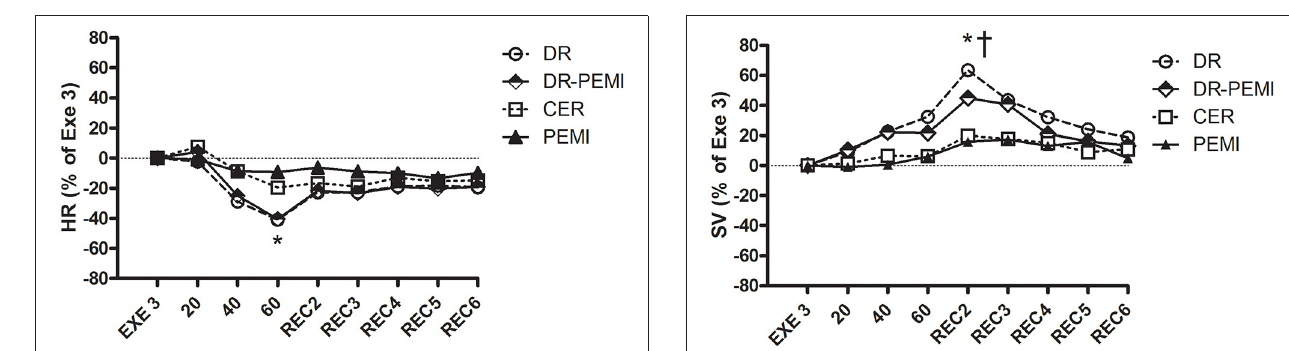
FIGURE 3 | SV time courses during all four tests. Values are means ± SD percentages of the end of handgrip (EXE3). * = P < 0.05 vs. EXE3. † = P < 0.05 vs.